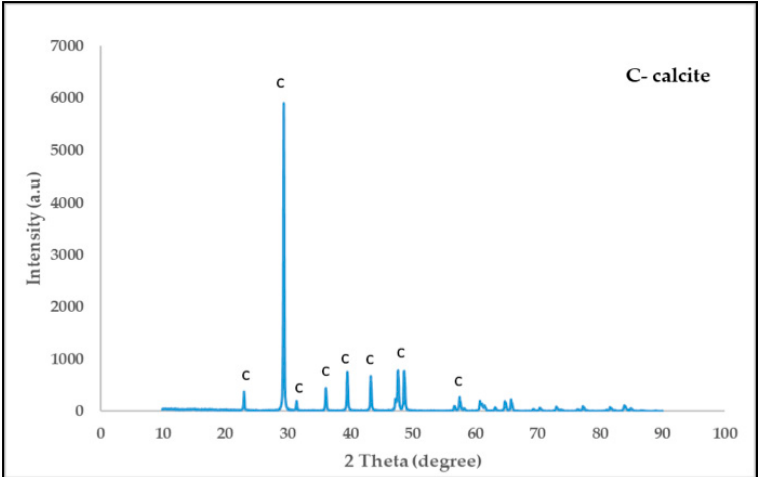
Figure 2. Raw eggshells and eggshell powder.